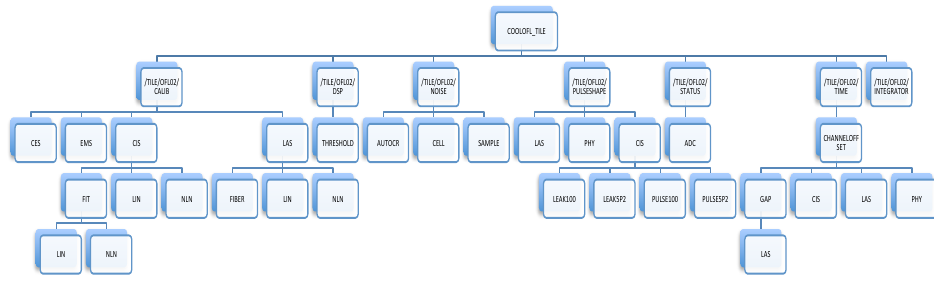
Fig. 2. Schema of COOL folders in TileCal Offline Conditions DB, CONDBR2 ORACLE